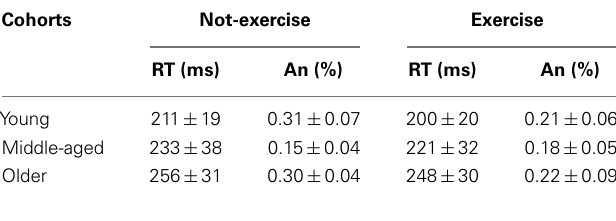
Table 1 | Mean and standard deviation (Mean ± SD) of the response times (RT) and anticipations (An) for each sub-cohort .